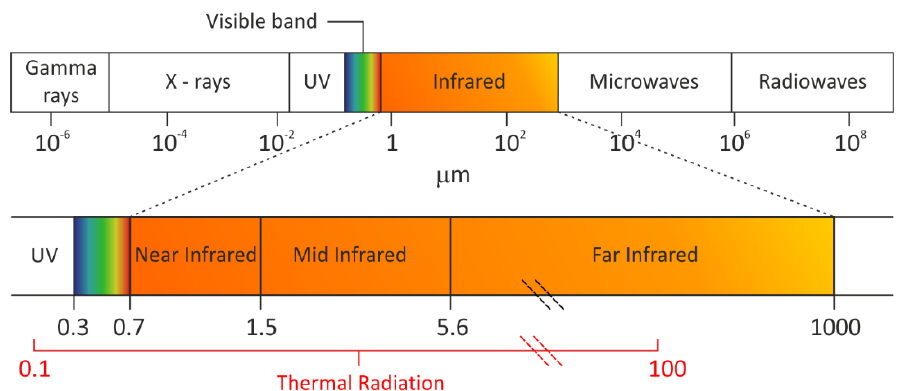
Figure 1. The electromagnetic spectrum with the range of occurrence of thermal radiation and the infrared band highlighted.